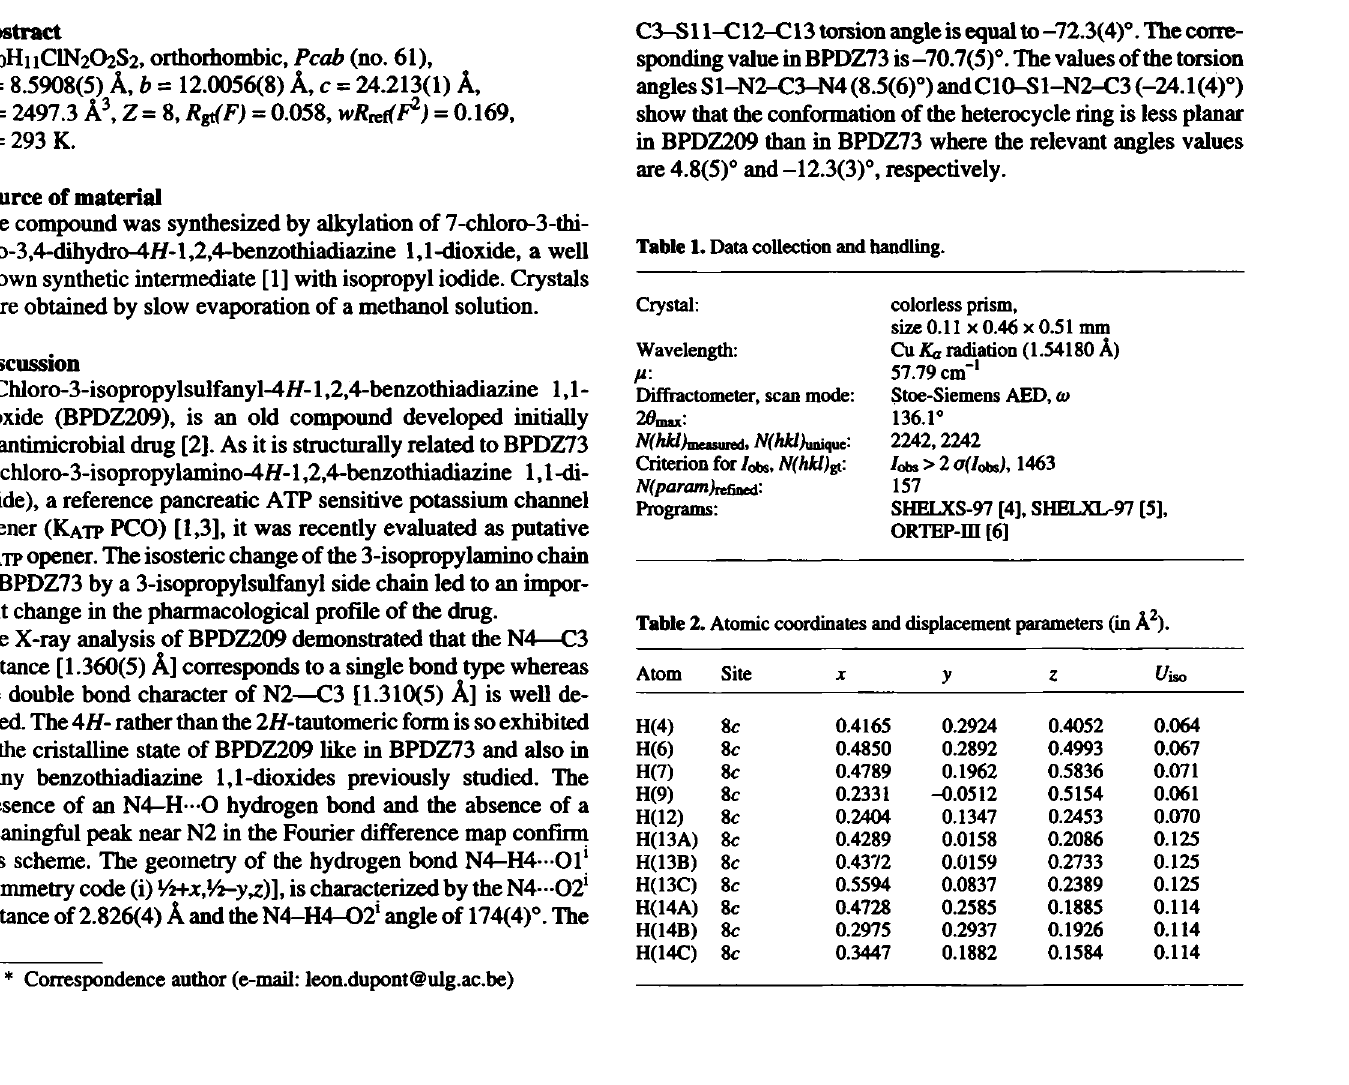
Table 1. Data collection and handling.